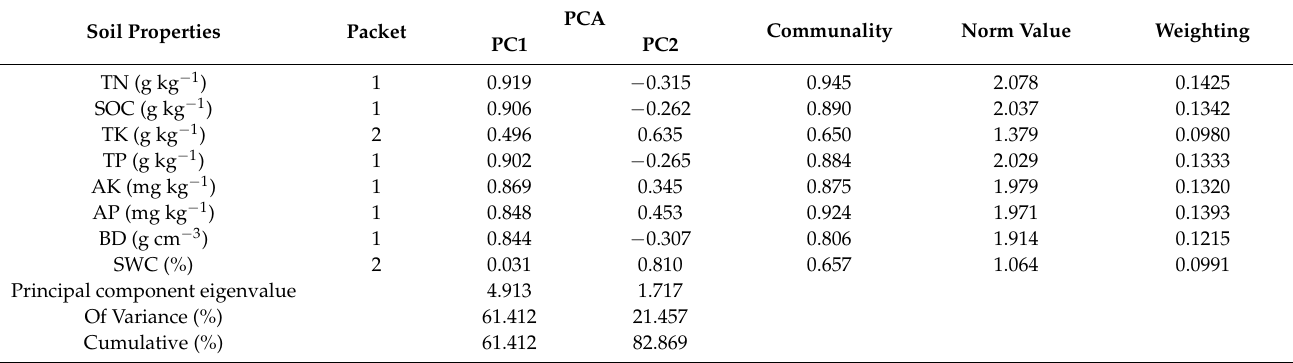
Table 5. Soil properties of factor pattern, common factor variance and weighting.